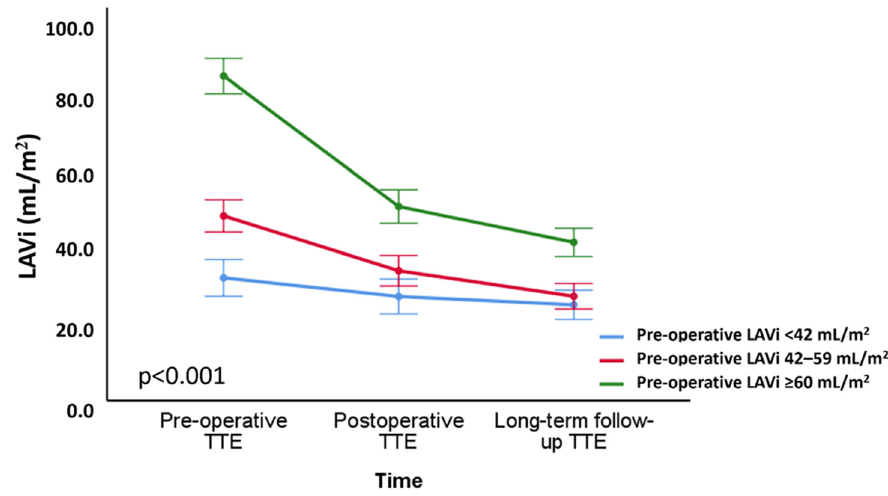
Figure 3. Changes in left atrium volume index over time according to the degree of preoperative left atrial dilatation. Changes in LAVi over time, according to three groups: patients with preoperativee LAVi < 42 mL/m 2 ( n = 68); patients with preoperative LAVi 42–59 mL/m 2 ( n = 88); patients with preoperative LAVi ≥ 60 mL/m 2 ( n = 70). LAVi = left atrium volume index; TTE = transthoracic echocardiography.